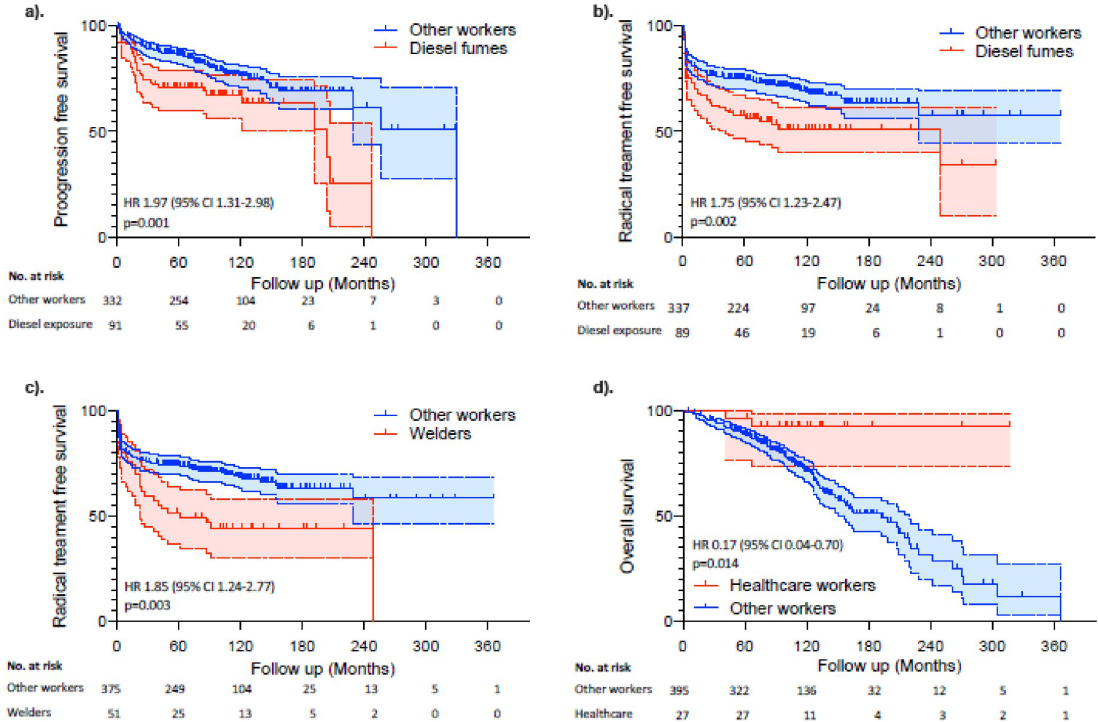
Fig 1. a. Progression free survival of bladder cancer of patients exposed and not exposed to occupational diesel fumes. b. Radical treatment free survival of bladder cancer of patients exposed and not exposed to occupational diesel fumes. c. Radical treatment free survival of bladder cancer of patients exposed and not exposed to occupational welding. d. Overall survival of bladder cancer from patients who were healthcare workers compared to any other form of work.